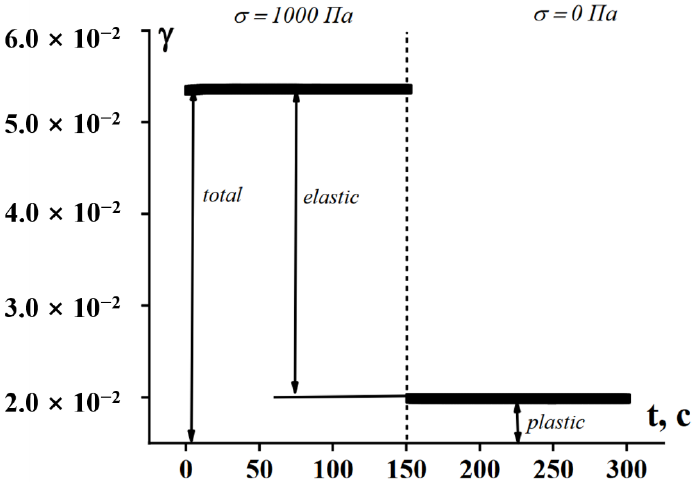
Figure 24. Elastoplastic behavior of a model feedstock based on 60% of Al 2 O 3 in polymer matrix. Left part—shearing under stress of 1000 Pa; right part—rest ( σ = 0) after cessation of stress.